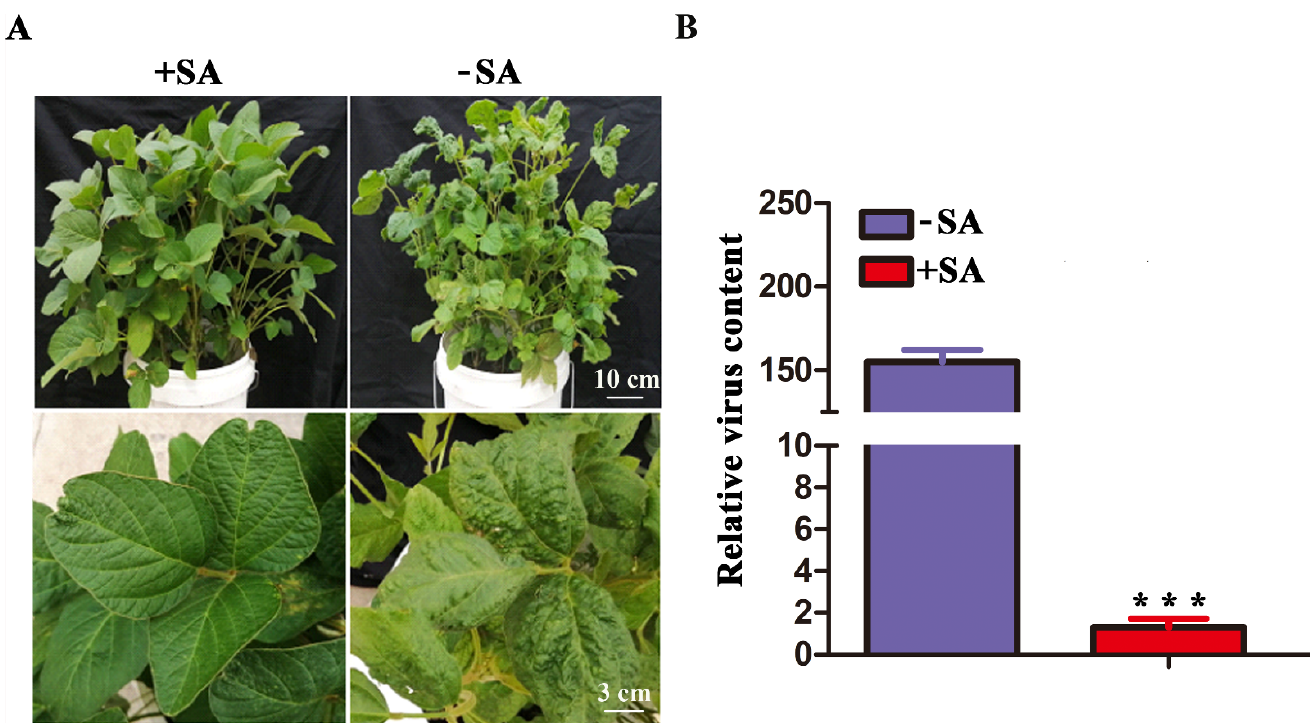
Figure 4. Spraying SA improved the resistance to SMV in soybeans. ( A ) Phenotypes of wild-type plants with (top left panel) and without (top right panel) SA treatment plants after SMV inoculation, respectively; close view of the newly expanded unifoliate leaves with (bottom left panel) and without (bottom right panel) were also shown. ( B ) Virus content in wild-type plants with and without SA treatment ( CP gene). Data represent the mean ± SD of three independent experiments at 35 days of SMV inoculation, with each experiment consisting of three technical replicates. The asterisks represent significantly different virus contents (Student’s t -test, ***, p < 0.001).